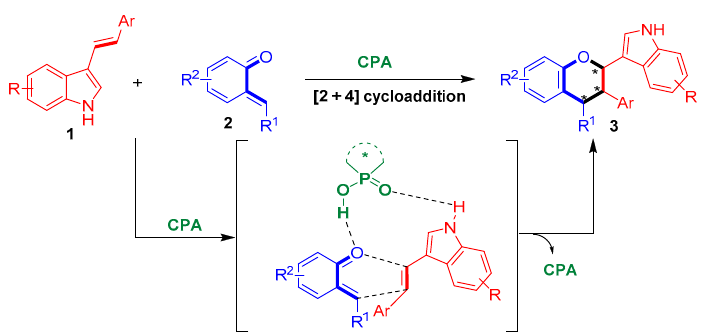
Figure 4. Design of CPA-catalyzed asymmetric [2 + 4] cycloaddition of 3-vinylindoles using o -QMs. The asterisk * indicates chiral center. The asterisk * indicates chiral